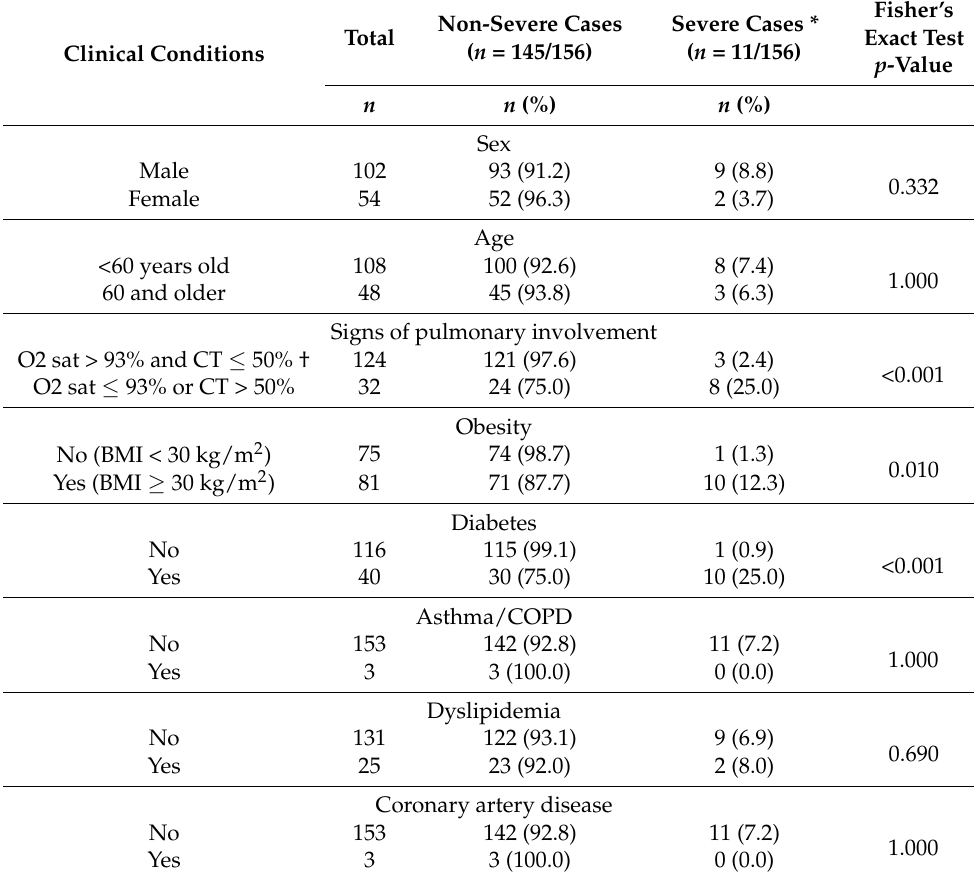
Table 1. Baseline patient characteristics according to progression to severe disease